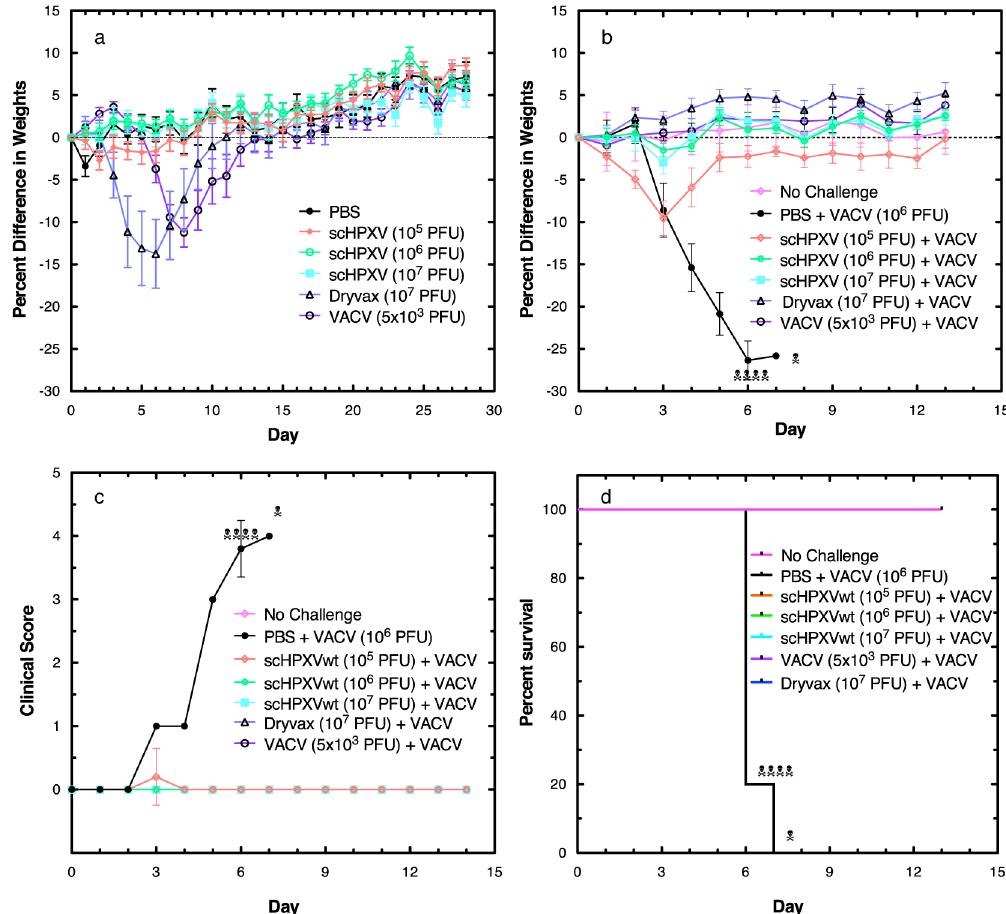
Fig 5. Virulence and vaccine properties of scHPXV. a . Virulencestudies. Immune competent BALB/c mice (5 per group) were inoculated intranasallywith the indicatedviruses. scHPXV was tested using doses rangingfrom 10 5 − 10 7 pfu per mouse. Some weight loss due to illnesswas seen in animalsinoculatedwith 5 × 10 3 pfu VACV strain WR (¢), or 1 × 10 7 pfu of VACV strain DPP15 ( Δ ), but no illness was detected in any of the animalsinfected with HPXV clones. b . VACV challenge studies. Four weeks after exposure to the indicatedagent as shown in panel a (or mock treatment with buffered saline), the mice were exposedto a lethaldose of VACV strain WR (1 × 10 6 pfu) by the same route (day 0 in b is day 28 in graph a ). The animalswere monitored for signs of diseaseand euthanized if the weight loss exceeded25% of the initial body weight. The scHPXV strain provided good protection at the two highestpre- challengedoses (1 × 10 6 and 1 × 10 7 pfu). c . Diseasecourse in HPXV vaccinatedmice. The mice were inspectedto detect four signs of disease(ruffled fur, hunchedposture, difficulty breathing, and reducedmobility)and a clinical score calculatedfrom the sum of the individualscores averaged across all five (or surviving) mice per cohort. Little or no signs of illness were detected in mice first vaccinatedwith 1 × 10 6 or 1 × 10 7 pfu scHPXV d . Kaplan-Meyer analysis of survivorship. All of the mock-vaccinated(i.e. saline-treated) mice succumbed to VACV strain WR challenge, whereastreatment of animals vaccinated with either VACV strain WR, VACV strain DPP15, or all doses of scHPXV (10 5 − 10 7 pfu per mouse) protected 100%of the